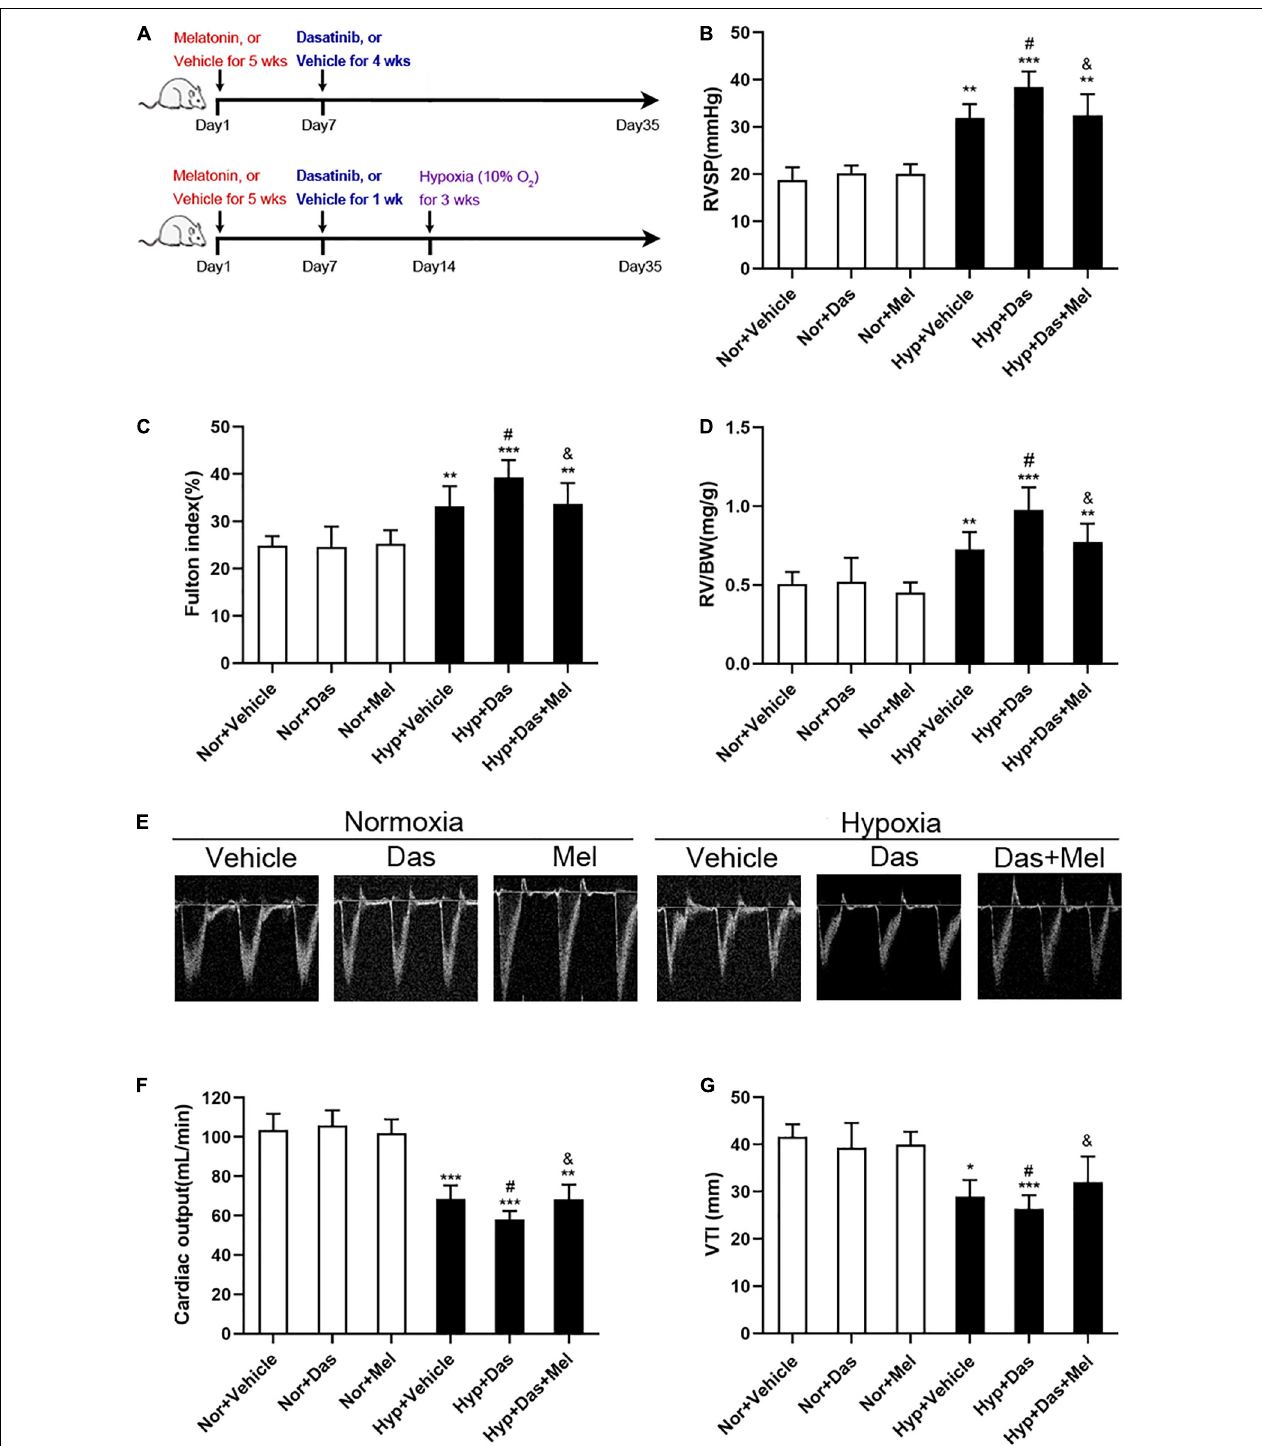
FIGURE 1 | Melatonin attenuates pulmonary hypertension induced by dasatinib under chronic hypoxia. Schematic of rat model used to study the in vivo effects of melatonin on pulmonary hypertension induced by dasatinib under hypoxia (A) . Values of right ventricular systolic pressure (RVSP) (B) , Fulton index (C) , RV/BW (D) . Echocardiography of right ventricle (E) . Values of cardiac output (F) and VTI (G) in melatonin or vehicle pretreated rats which were exposed to dasatinib or vehicle under hypoxia or normoxia. Values are means ± SEM, ***P < 0.001, **P < 0.01, *P < 0.05 compared with Nor + Vehicle group. # P < 0.05 compared with Hyp + Vehicle group. & P < 0.05 compared with Hyp + Das group ( n = 6).